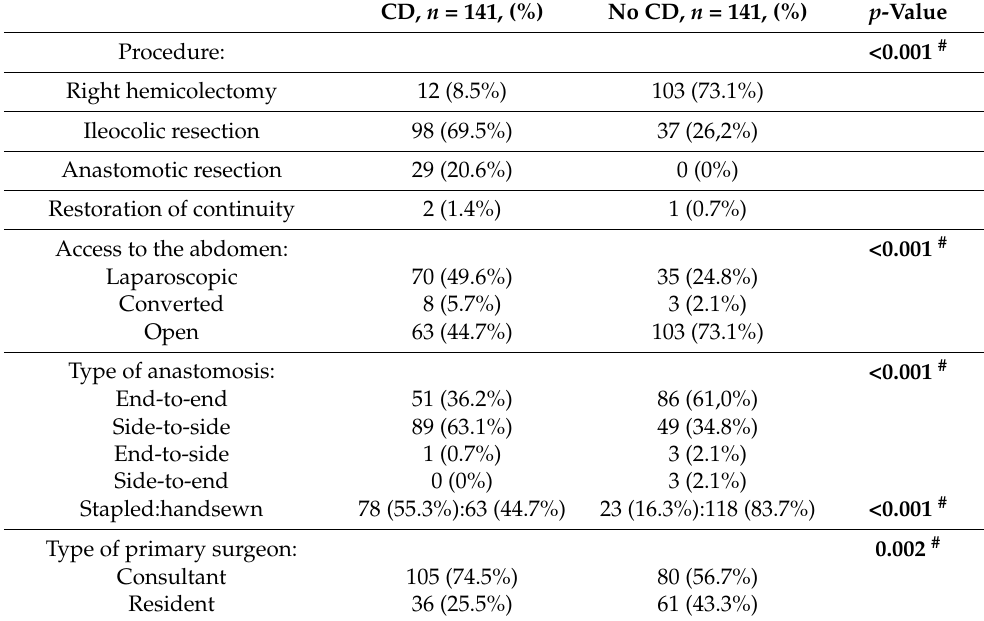
Table 2. Surgical details.